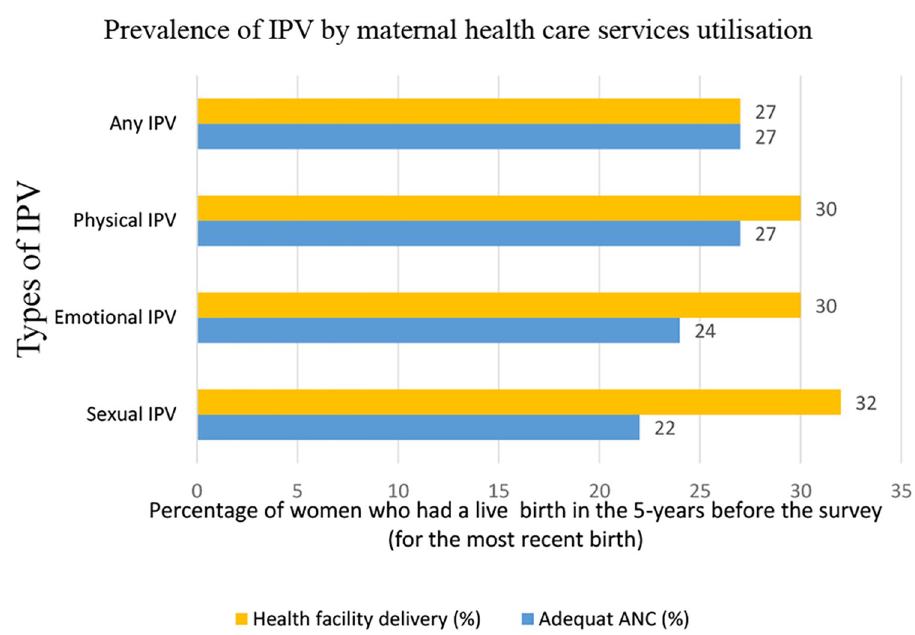
Fig 1. Prevalence of maternal healthcare service use among women’s who reported exposure to intimate partner violence in Ethiopia (2016,